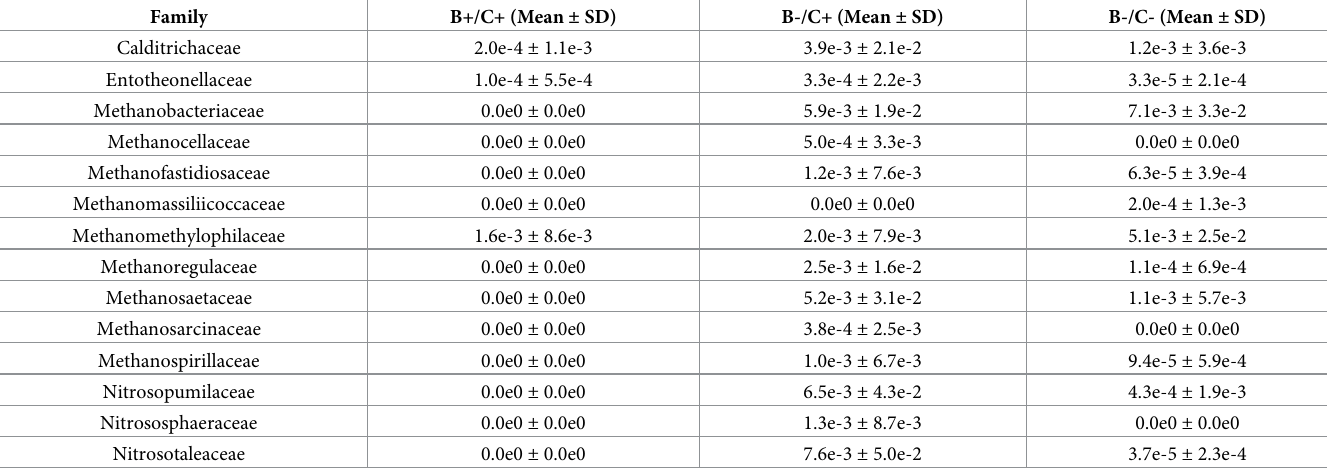
Table 1. Mean relative abundances of archaeal families identified in the study